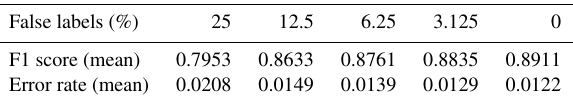
Figure 11. The statistical distribution of the classifier’s perfor- mance for the different number of training/test iterations is illus- trated. Each box plot is based on 10 independent sets of training/test iterations. The F1 score saturates after 9 iterations and validates our choice of 10 iterations. Table 3. Influence of falsely labeled data points on the test perfor- mance. Shown are the mean values over 10 training/test